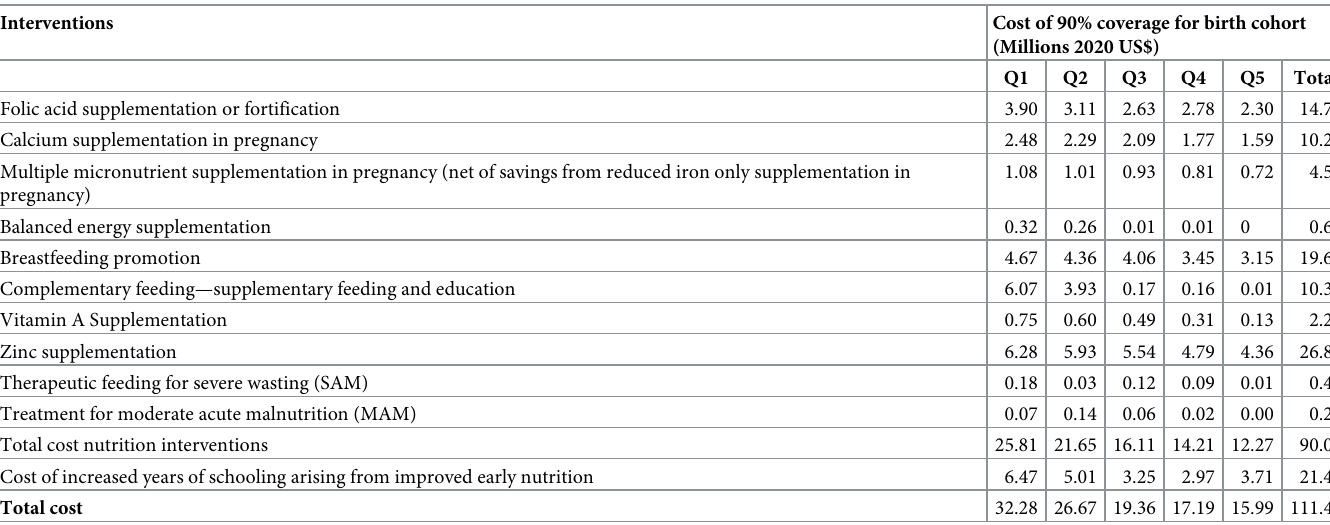
Table 2. Cost of increasing coverage of nutrition interventions to 90% and cost of consequential increases in years of schooling, by socio-economic quintile. Interventions